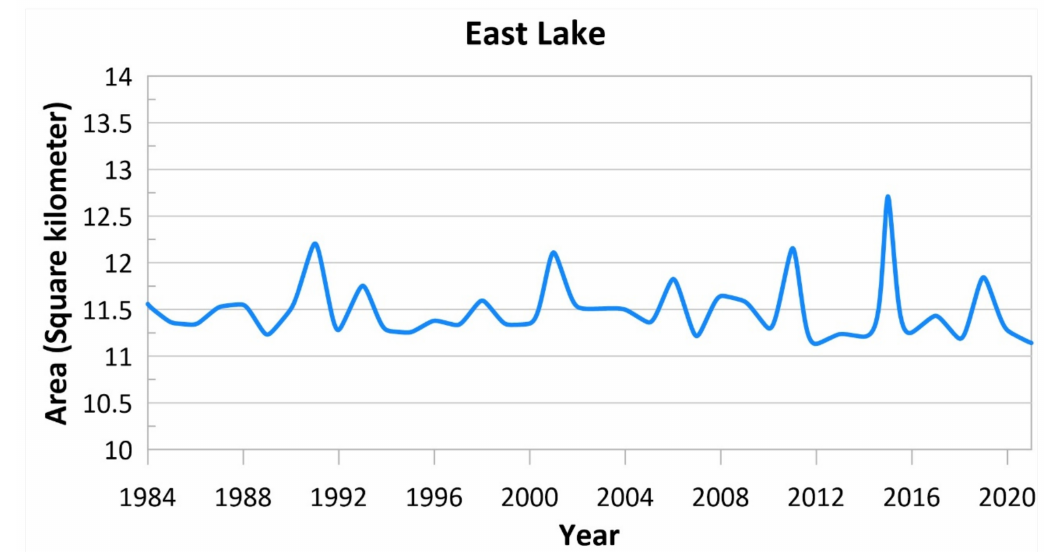
Figure 11. Spatiotemporal monitoring of East Lake from 1984 to 2021.